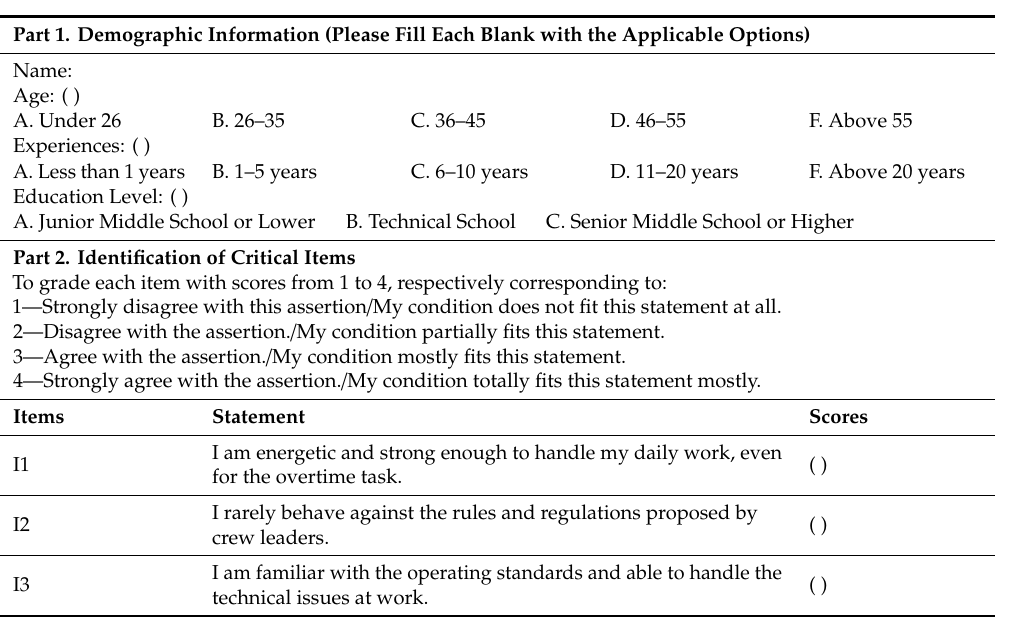
Table A1. Questionnaire for construction workers’ safety